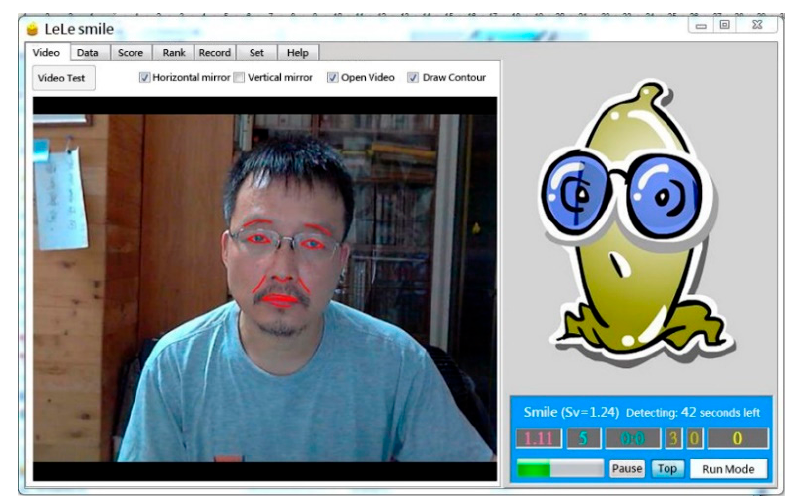
Figure 6. Image in which a smile is not detected.